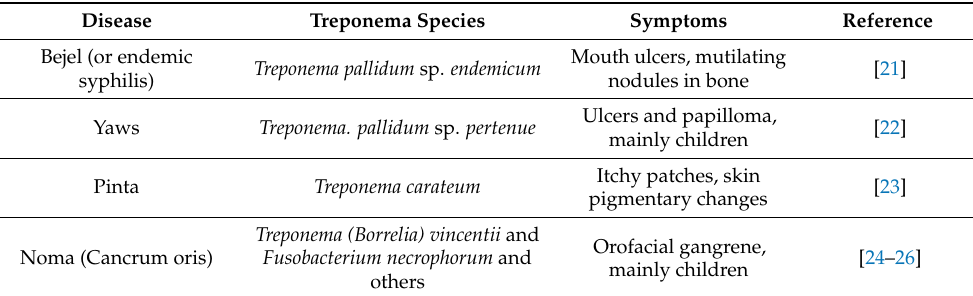
Table 2. List of endemic nonvenereal treponematoses.